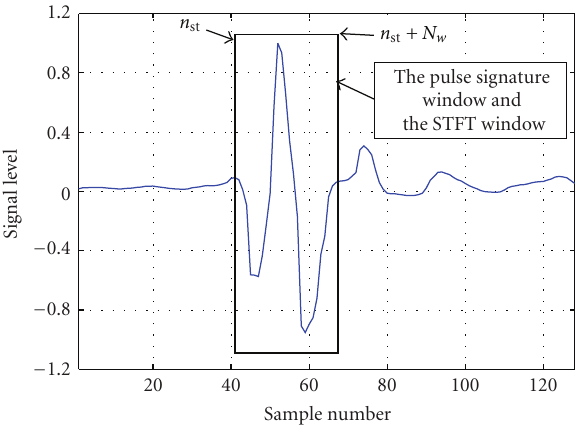
Figure 6: The pulse signature is defined by the main lobes (inside the pulse signature window) of the averaged target signals over 20 di ff erent targets measured in anechoic chamber. The same window sliding through the target signal sequence is used for STFT in pulse- spectrum signature